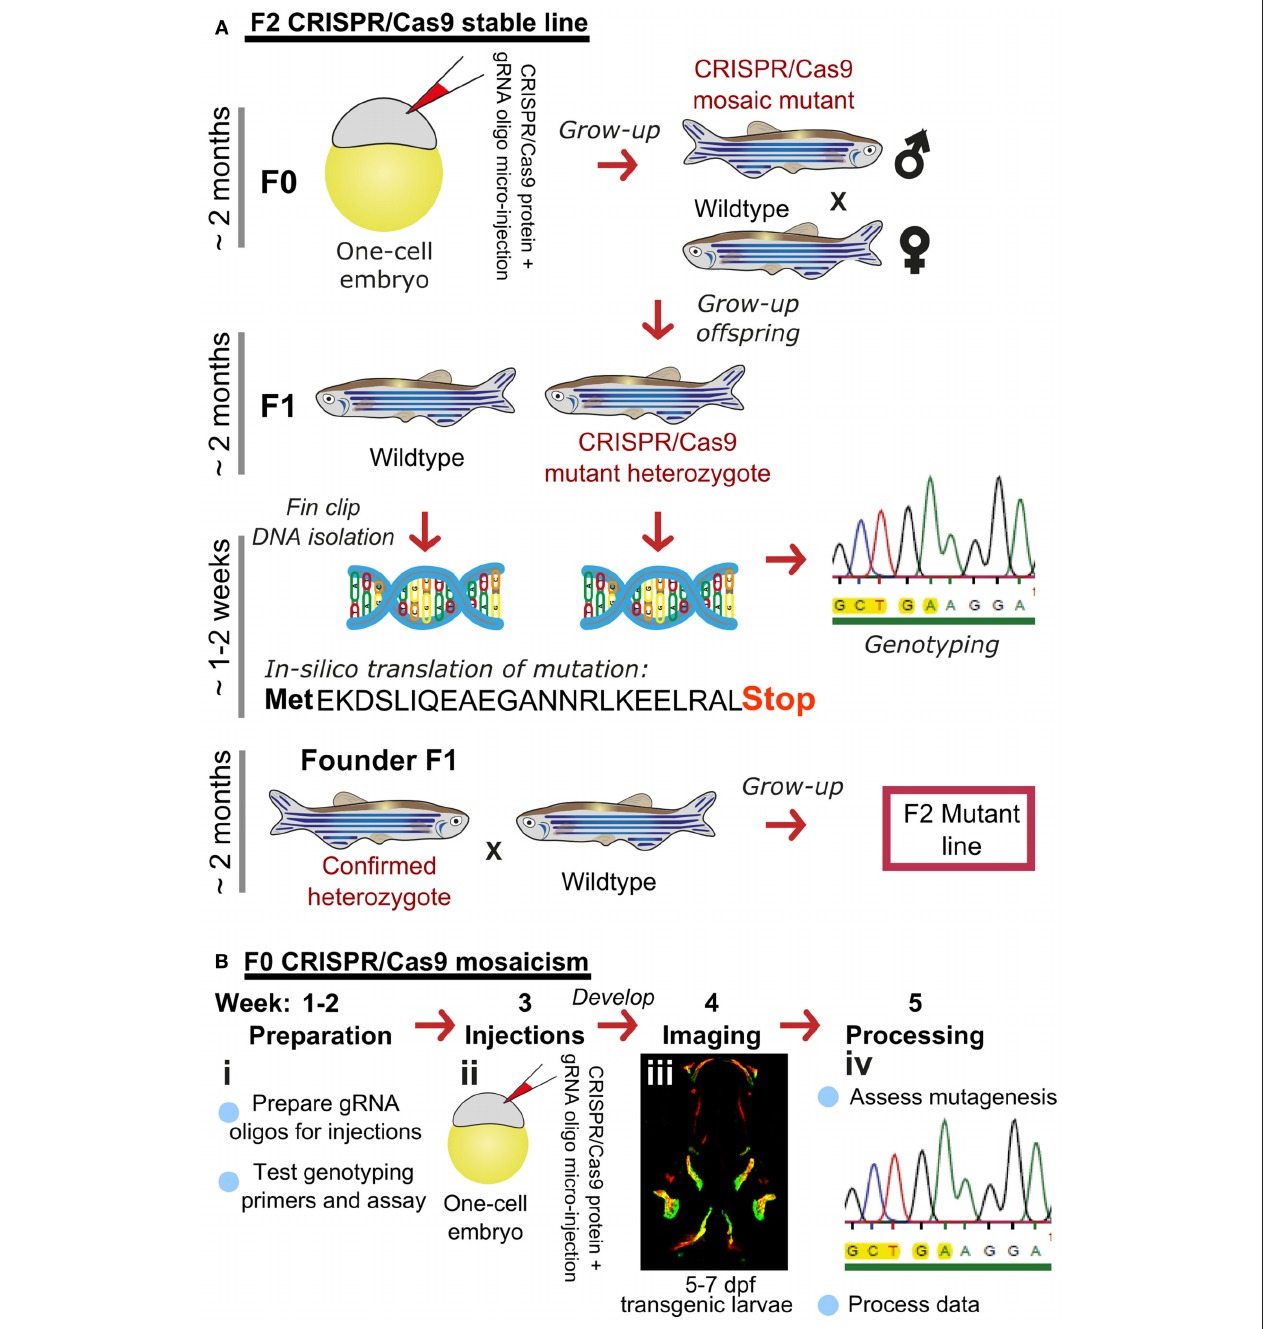
FIGURE 1 | Rapid and efficient mutagenesis using CRISPR/Cas9 genome editing in zebrafish. (A) To generate a stable mutant line, F0 CRISPR/Cas9 injected individuals carrying mosaic mutations (defined by fin-clipping, B ) should be outcrossed to wildtype fish to allow selection of a single germline mutation. Out-crossing the founder to wildtype will establish a stable F2 mutant line. Note that the F1 can have multiple founders with damaging mutations, incrossing these will result in F2 homozygotes (for recessive alleles) for functional analysis. When performing incrosses from F2, it will take another 2 months of breeding time. (B) This rapid protocol can be used to generate mutations in a gene of interest using CRISPR/Cas9 RNA or protein with gRNAs targeted against the gene from custom made gRNA oligos (i). Micro-injection of CRISPR/Cas9 RNA or protein and gRNAs specific to gene of interest into embryos at the single cell stage (ii) generating double stranded breaks during the first few rounds of cell divisions. The repair machinery is prone to errors and those cells will carry a different type of mutation giving a range of insertion and deletion (indel) mutations (spectrum of mutations, mosaicism). The overall mutagenic efficiency is typically high (around 80% with fragment analysis) allowing larval skeletal phenotypes to be assessed in the injected (F0) population (60). After imaging an Alizarin Red S (AR) stained individual in a transgenic background (here osteoblast marker sp7:gfp )(iii), mutagenesis assessment such as fragment analysis will determine a quantified mutagenesis rate (61) which can be correlated to a phenotype (iv). Note that mosaic mutants (crispants) can also be grown up to see the effect on the adult skeleton.